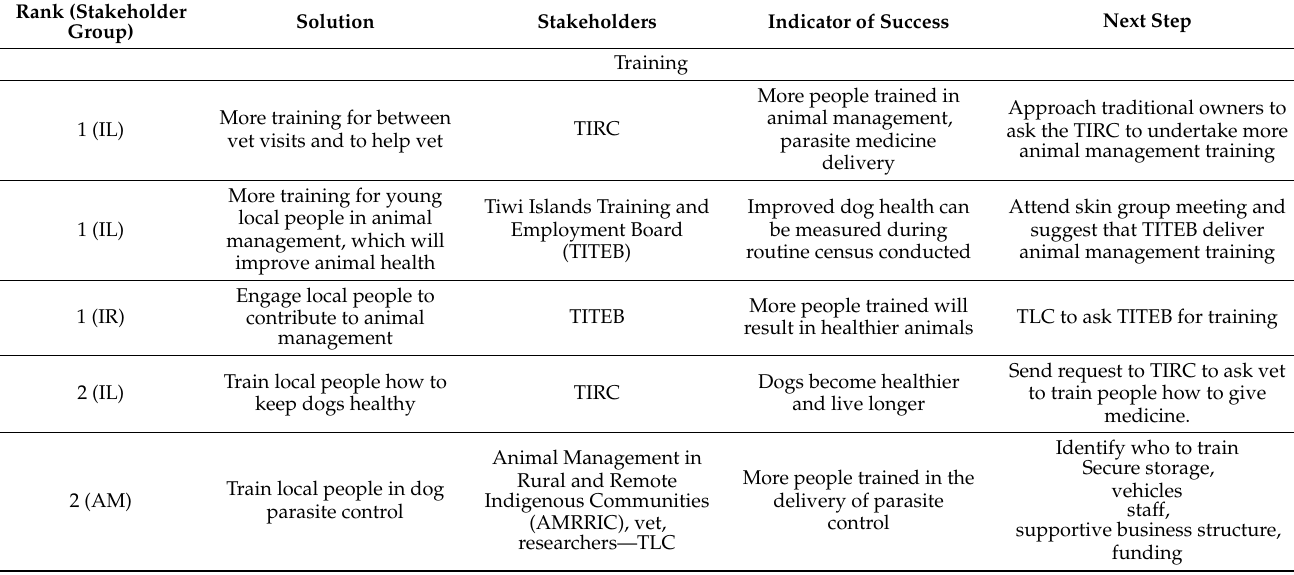
Table 2. Combined solutions identified by the 10 focus groups that participated in the causal loop analyses. Rank (Stakeholder